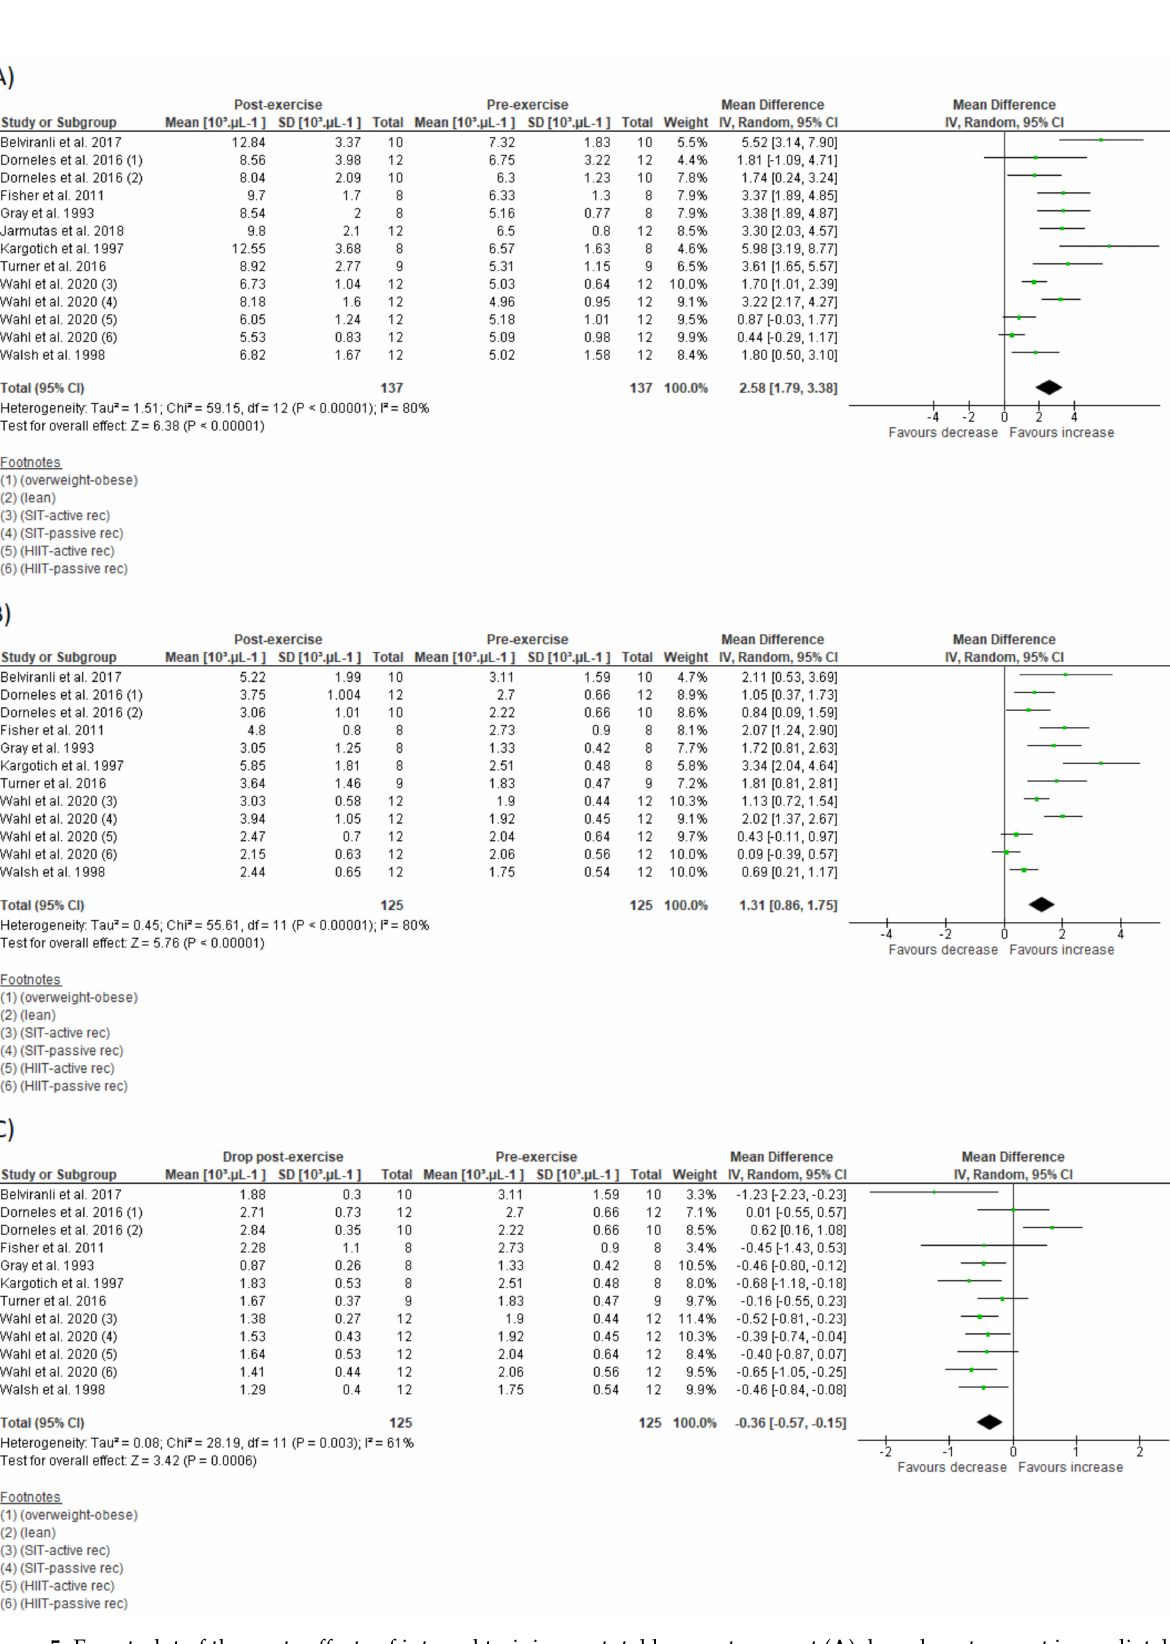
Figure 5. Forest plot of the acute effects of interval training on total leucocytes count ( A ), lymphocyte count immediately after exercise ( B ), and lymphocyte count at first drop during recovery ( C ). SD standard deviation, CI confidence interval, IV random effects. The green squares represent the mean difference for each dataset. The black diamonds represent the estimated overall